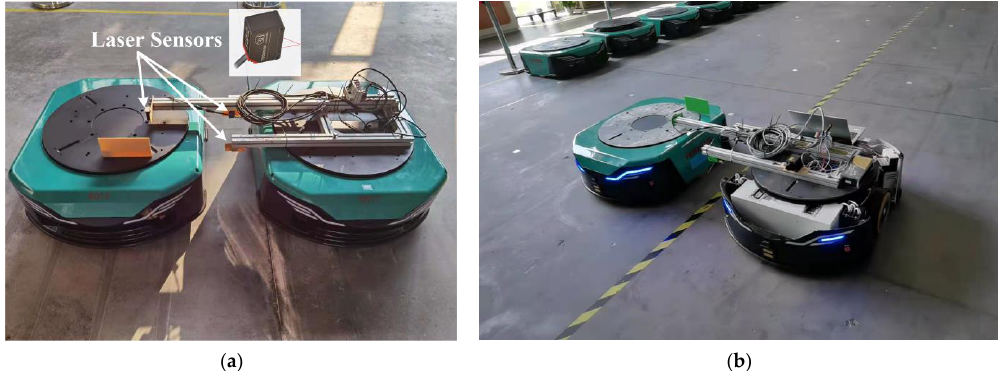
Figure 12. Experiments systems: ( a ) AGVs with measurement systems; ( b ) Experiment operation.